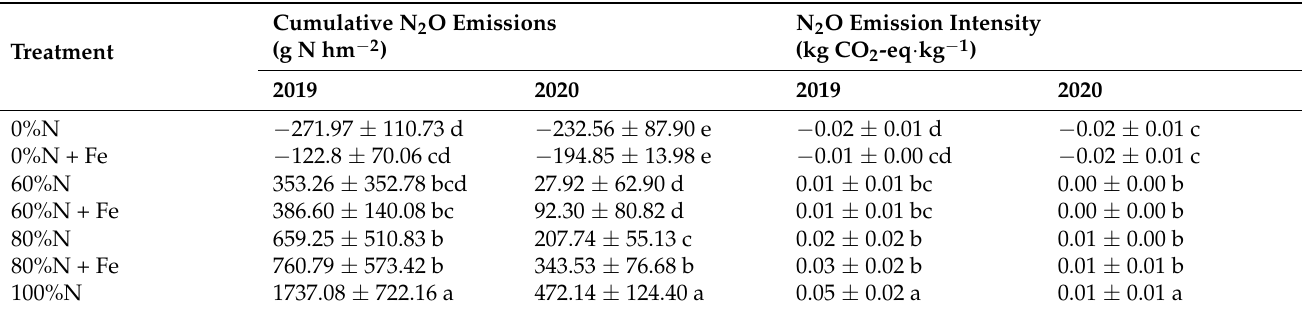
Table 3. Cumulative nitrous oxide (N 2 O) emissions and N 2 O emission intensity under various nitrogen fertilization rates with or without iron amendment in two rice-growing seasons.